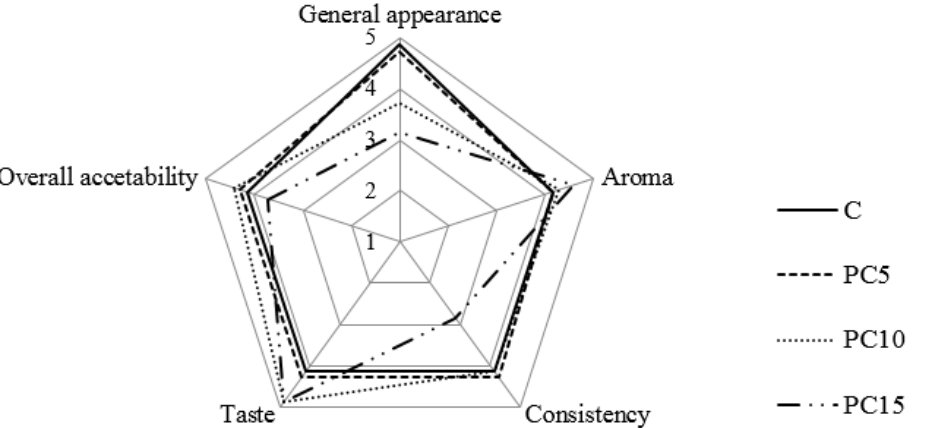
Figure 2. Sensory evaluation of oatmeal cookies with poppy seed expeller added: C—control probe, PC5—oatmeal cookies with 5% poppy seed expeller added; PC10—oatmeal cookies with 10% poppy seed expeller added; PC15—oatmeal cookies with 15% poppy seed expeller added.